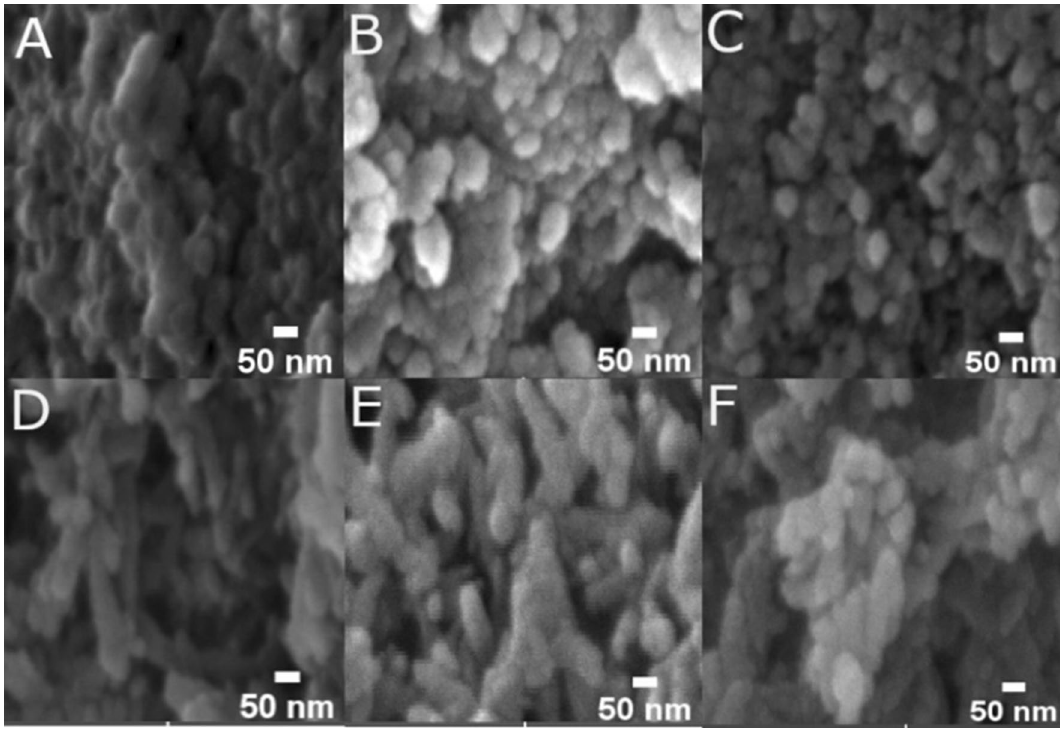
Figure 3. Scanning electron microscopy (SEM) images of the synthesized nanoparticles. ( A ) Hydroxyapatite (HAP), ( B ) Magnesium doped hydroxyapatite (MgHAP), ( C ) Zinc doped hydroxyapatite (ZnHAP), ( D ) Hydroxyapatite-urea (HAU), ( E ) Magnesium doped hydroxyapatite-urea (MgHAU), and ( F ) Zinc doped hydroxyapatite-urea